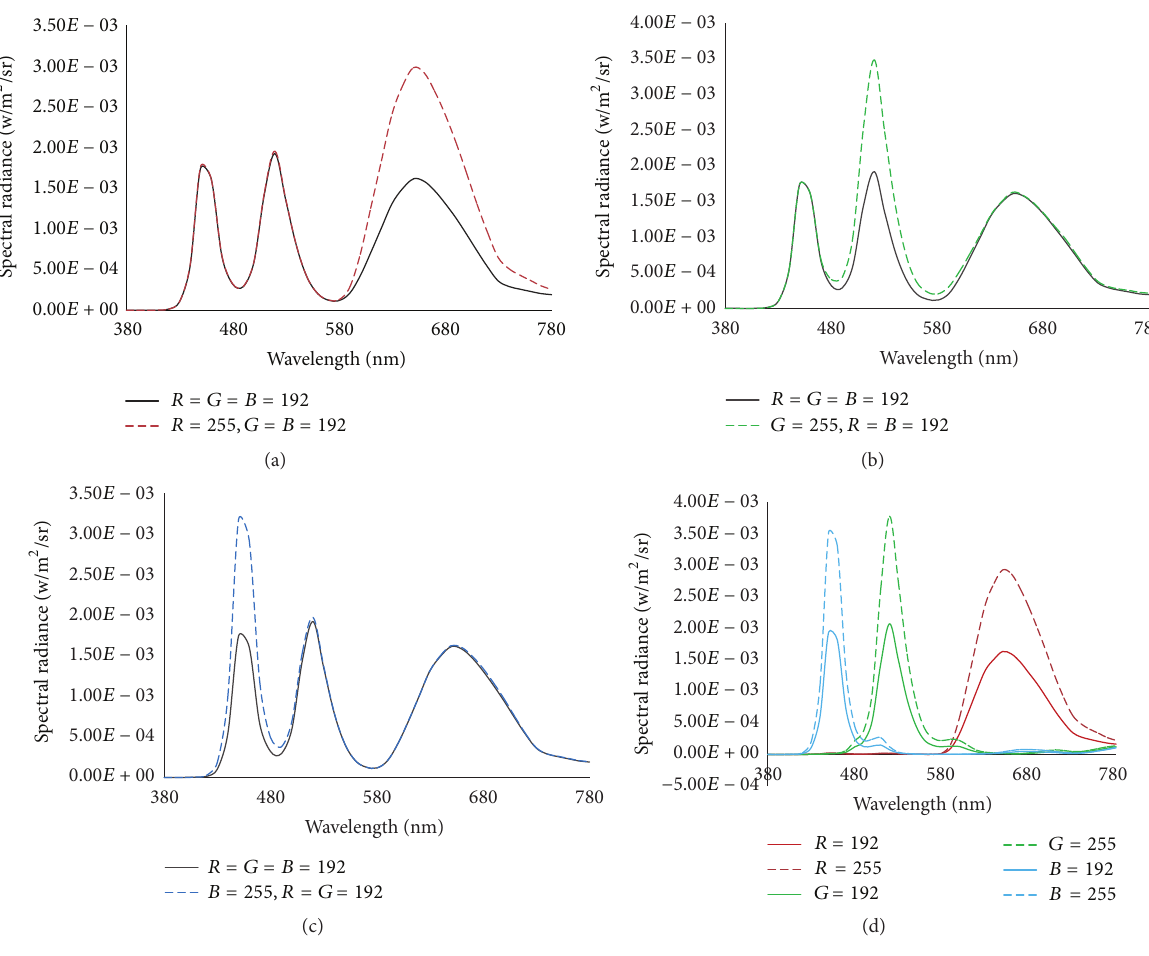
Figure 1: The spectral radiation curves with different digital input values for EIZO